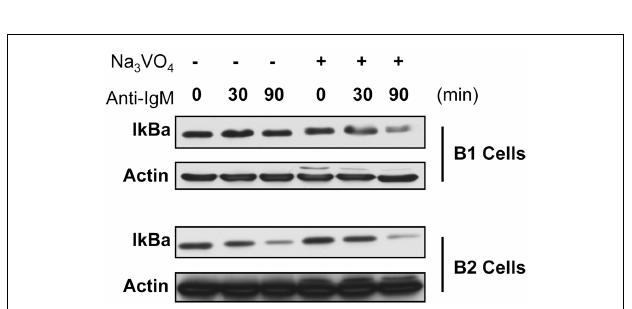
FIGURE 1 | I-kappa-B-alpha degradation and IKKalpha/beta phosphorylation analysis in response to anti-IgM in B-1a cells . Sorted peritoneal B-1a and splenic B-2 cells were treated with anti-IgM (15 µ g/ml) for the times indicated at 37°C. Afterward, the cells were washed, pelleted, lysed, and then used for western blot analysis. Results shown are representative of three independent experiments.